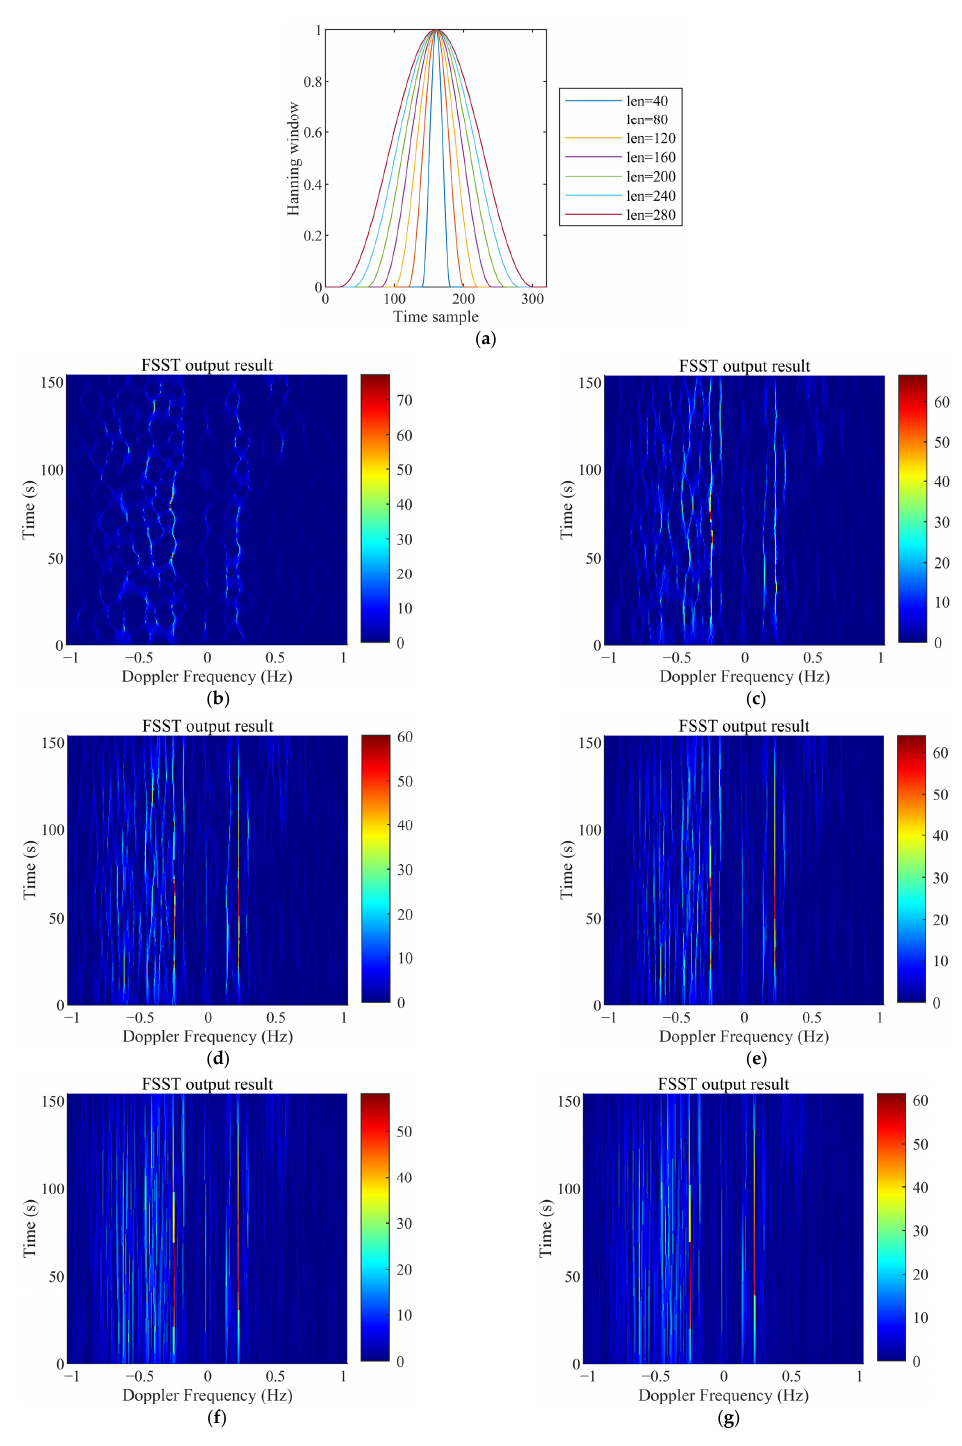
Figure 4. FSST results of Hanning window with different parameters: ( a ) Hanning window; ( b ) the FSST results of len = 40; ( c ) the FSST results of len = 80; ( d ) the FSST results of len = 120; ( e ) the FSST results of len = 160; ( f ) the FSST results of len = 200; ( g ) the FSST results of len =